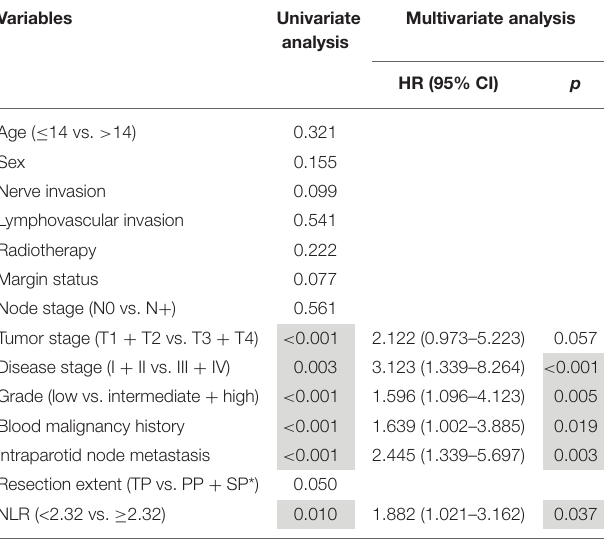
TABLE 2 | Predictors for recurrence-free survival in pediatric patients with parotid mucoepidermoid carcinoma. Variables Univariate